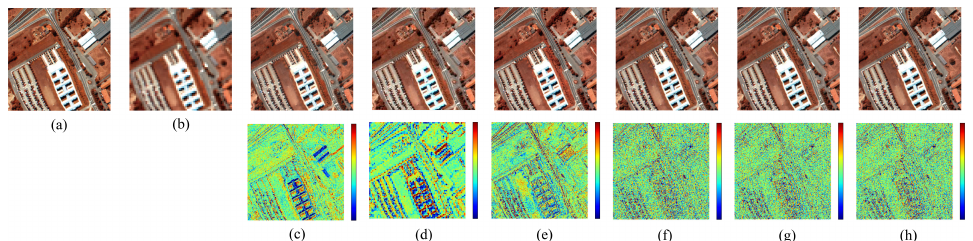
Figure 9. Comparison of fusion results on the Pavia University dataset. ( a ) Reference Image; ( b ) LR-HSI; ( c ) CNMF; ( d ) HySure; ( e ) NLSTF; ( f ) CSTF; ( g ) UTV-HSISR; ( h )